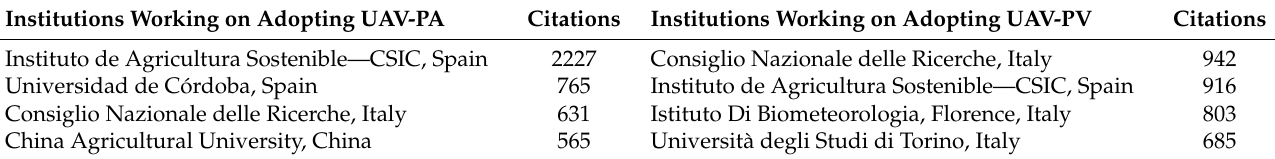
Table 6. Leading institutions working on adopting UAV-PA and